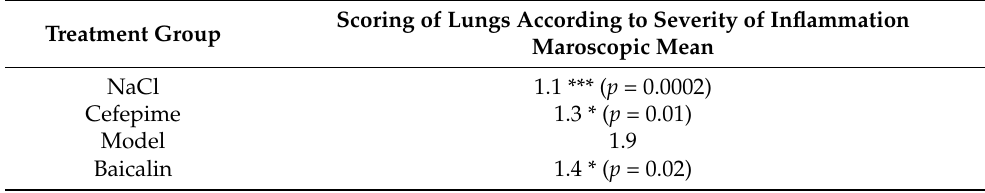
Figure 6. Microscopic changes of the lung tissues of the different animal groups (H&E staining, magnification: ×200). Panels ( A – D ) show pathology of Model group, Blank uninfected control